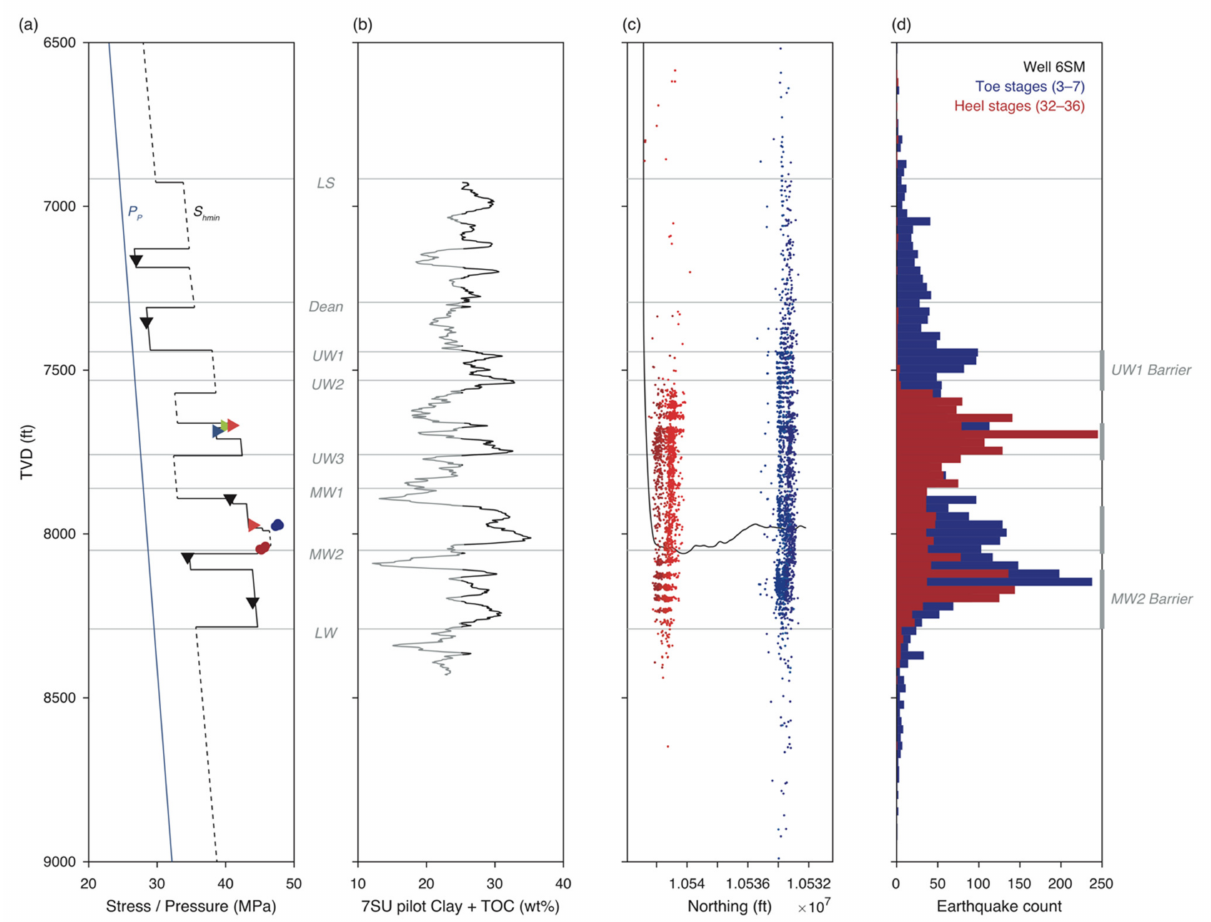
Figure 6. Relationship between stress, composition, and seismicity in well 6SM. ( a ) Interpreted stress profile including DFITs from vertical wells (black triangles), DFITs from horizontal wells (colored triangles), and instantaneous shut-in pressure (ISIP) for 6SU stages 3–7 (blue points) and 32–36 (red points). ISIP values are expected to be ~3–5 MPa higher than DFITs. ( b ) Clay + TOC in the 7SU pilot well. ( c ) Distribution of microseismic events colored by stage from the five toe stages (blue) and five heel stages (red to orange). ( d ) Histogram of microseismic event depths from the five toe stages (blue) and five heel stages (red to